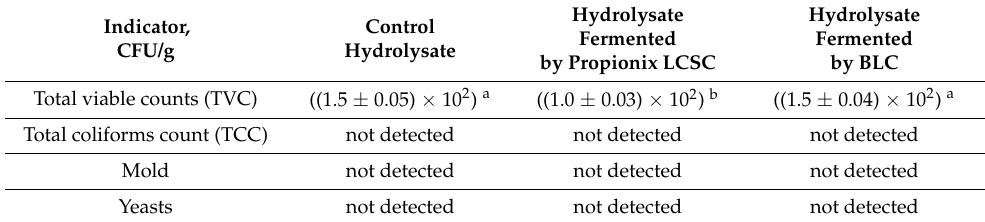
Hydrolysate Control Fermented Hydrolysate by Propionix LCSC not detected not detected not detected